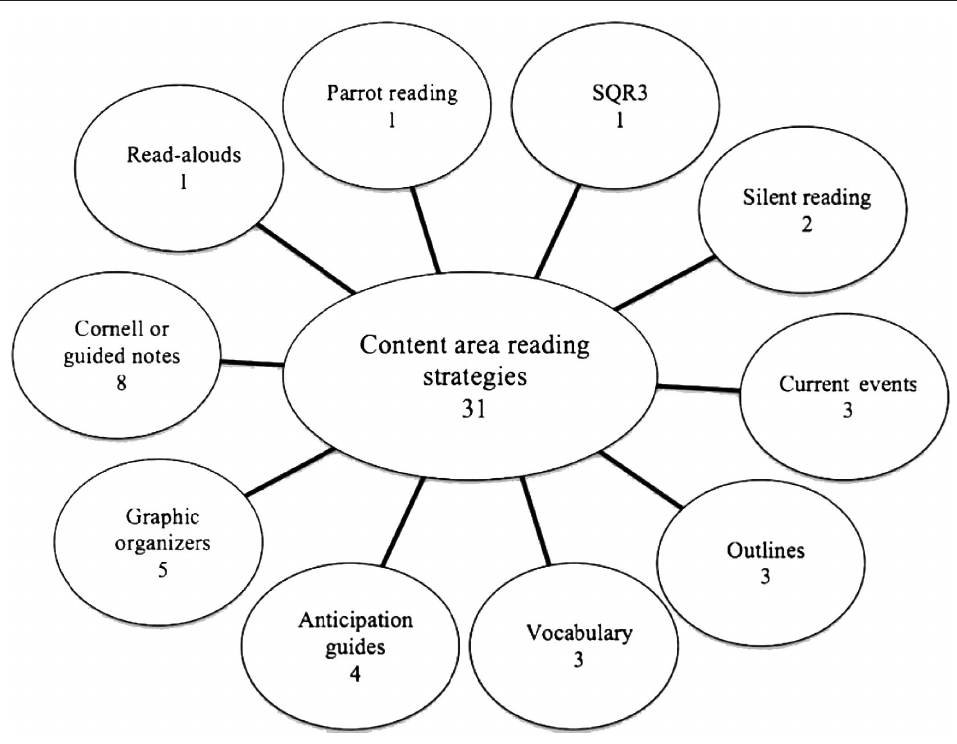
Figure 1: Content area reading strategies that teachers identified teaching